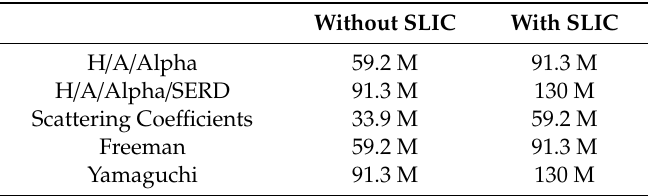
Table 10. Memory Usage Condition of